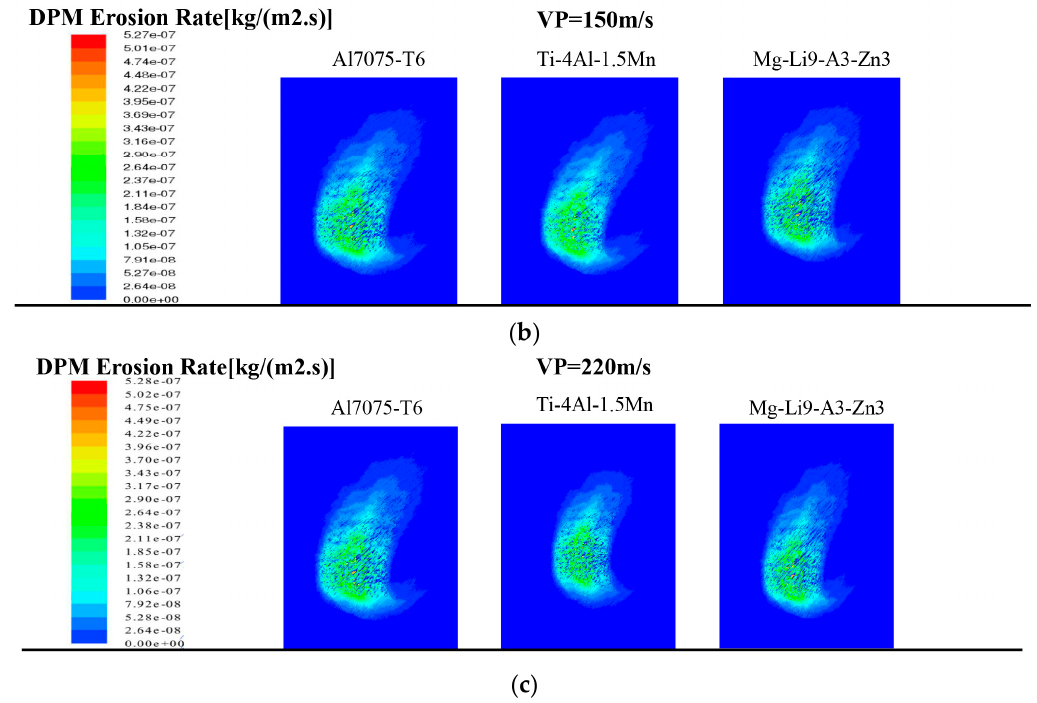
Figure 9. Three-dimensional erosion rates of three materials at different impact speeds at 0° angle of attack: ( a ) V P = 70 m/s; ( b ) V P = 150 m/s; ( c ) V P = 220 m/s. Table 6. Average accretion rates of the three material at di ff erent impact